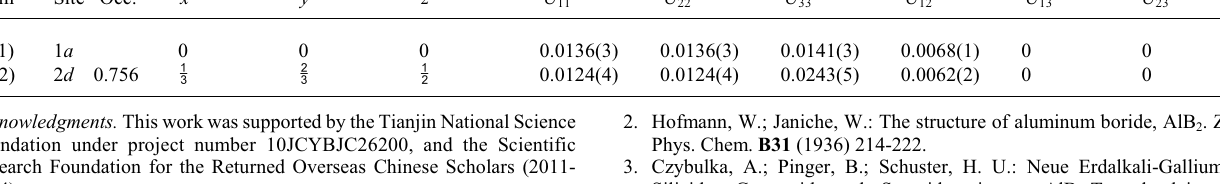
Table 2. Atomic coordinates and displacement parameters (in Å 2 ) . Atom Site